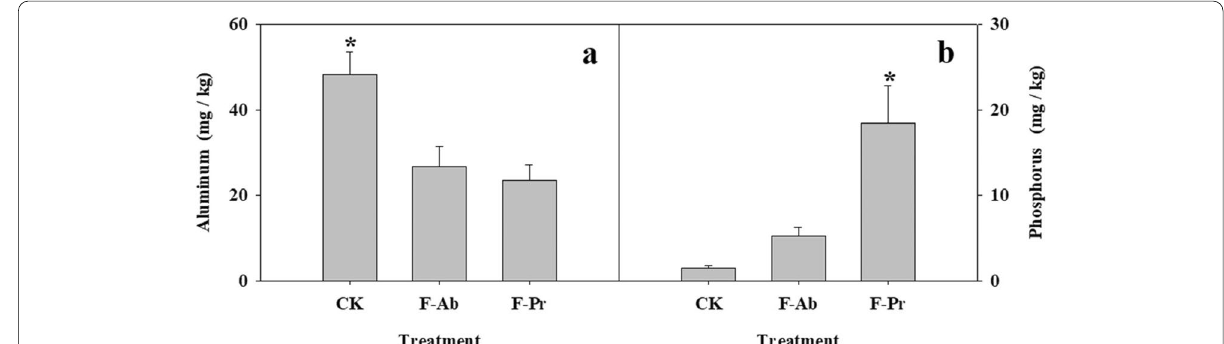
Fig. 4 Effect of Litsea cubeba cover on soil mineral nutrition of tea plantation. a Aluminum. b Phosphorus. Data are means indicates significant difference between treatments at 0.05 level; CK, control; F‑Ab, the vegetative branches cover treatment; F‑Pr, the fruit‑bearing branches cover treatment